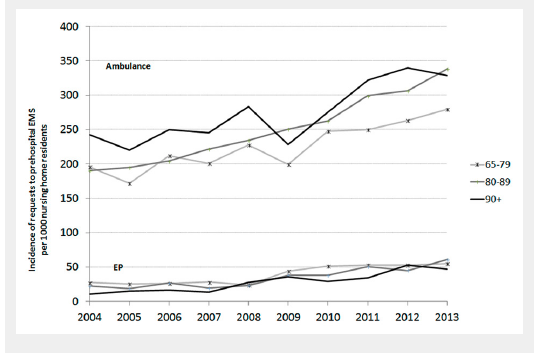
Evolution of the annual incidence of requests to ambulance or emergency physicians(EPs) per 1,000 nursing home residents in the Canton of Vaud, by age